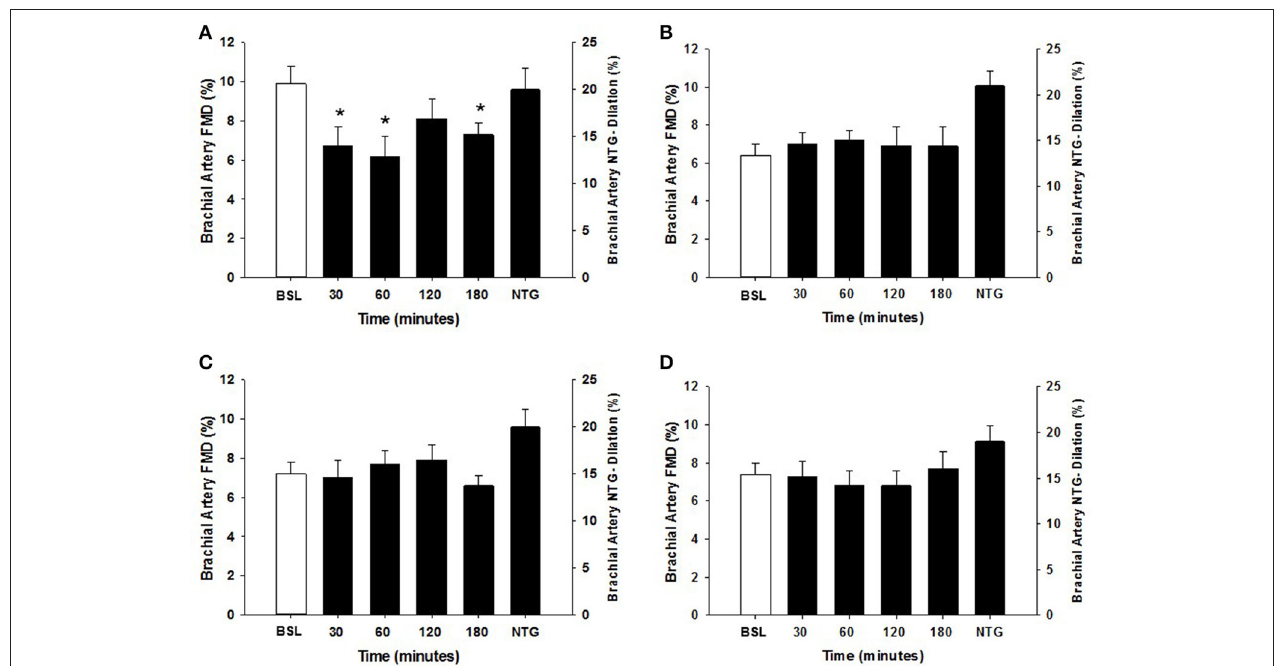
FIGURE 2 | Brachial artery FMD responses to a 75g glucose high sugar meal (HSM) at baseline, and 30, 60, 120, and 180min post-ingestion in (A) sedentary participants ( n = 11), (B) runners ( n = 12), (C) weight lifters ( n = 13), and (D) cross-trainers ( n = 9). Brachial artery FMD scale is on the left Y-axis. Nitroglycerin (NTG) mediated dilation is depicted on the right Y-axis. All data presented as mean ± SEM. *Indicates significant difference compared to baseline FMD measure (adjusted P < 0.05; Sidak-Bonferroni adjustment for ANOVA multiple comparisons).